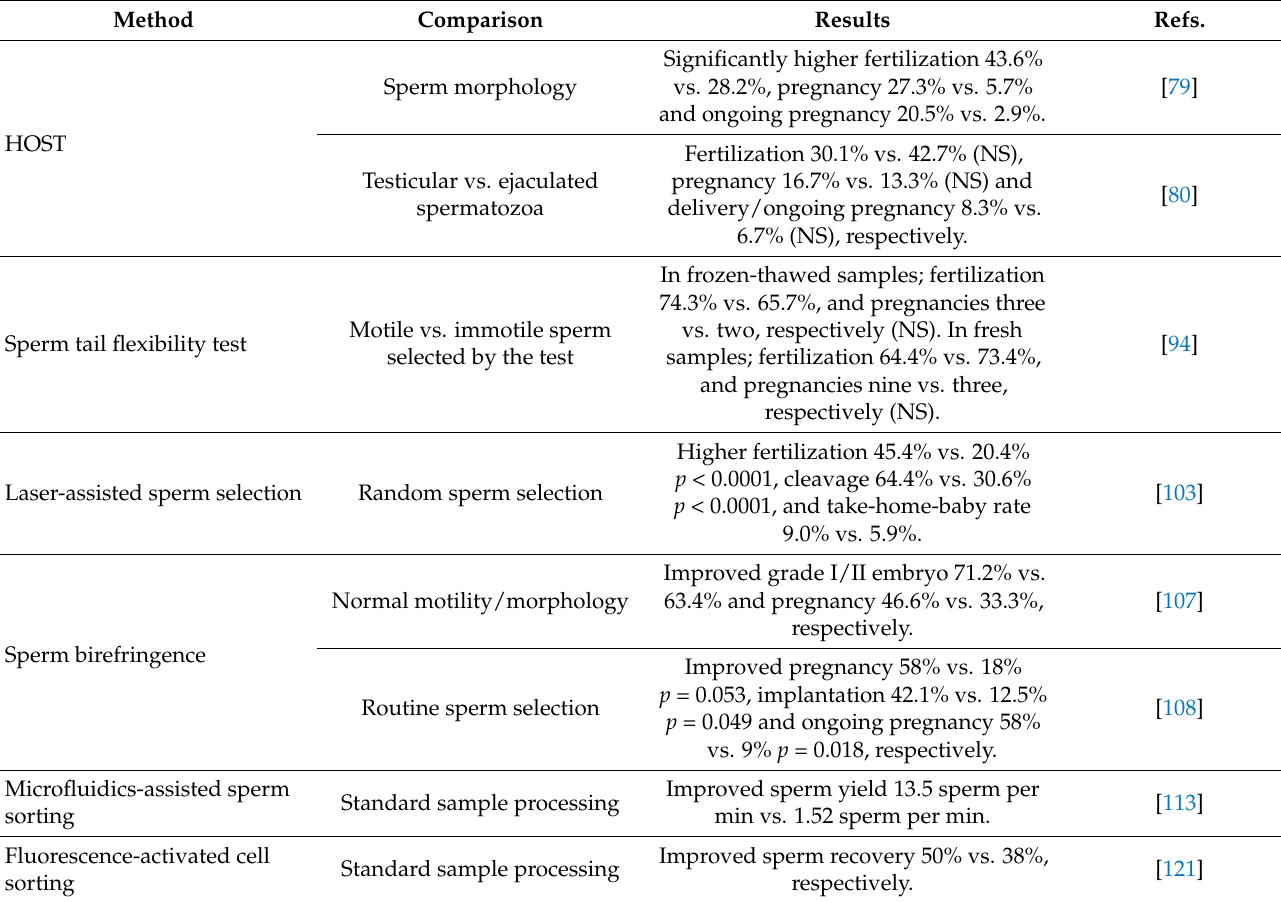
Table 4. Clinical outcomes of different methods for viable sperm recovery by TESE. NS: no significant. Method